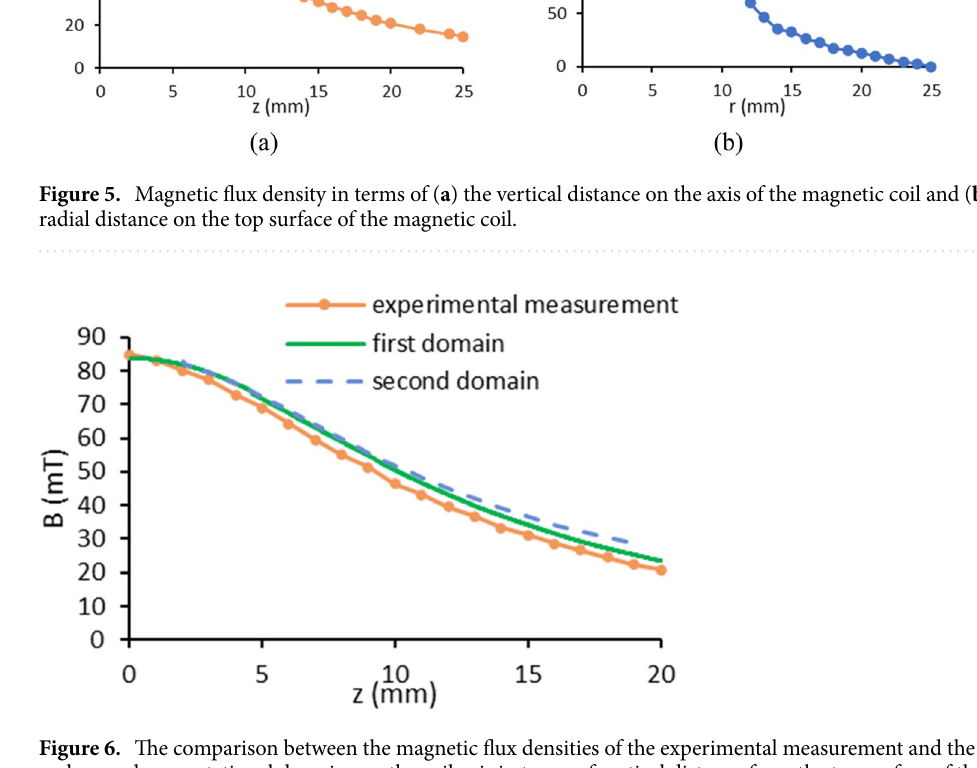
Figure 6. The comparison between the magnetic flux densities of the experimental measurement and the first and second computational domains on the coil axis in terms of vertical distance from the top surface of the magnetic coil.